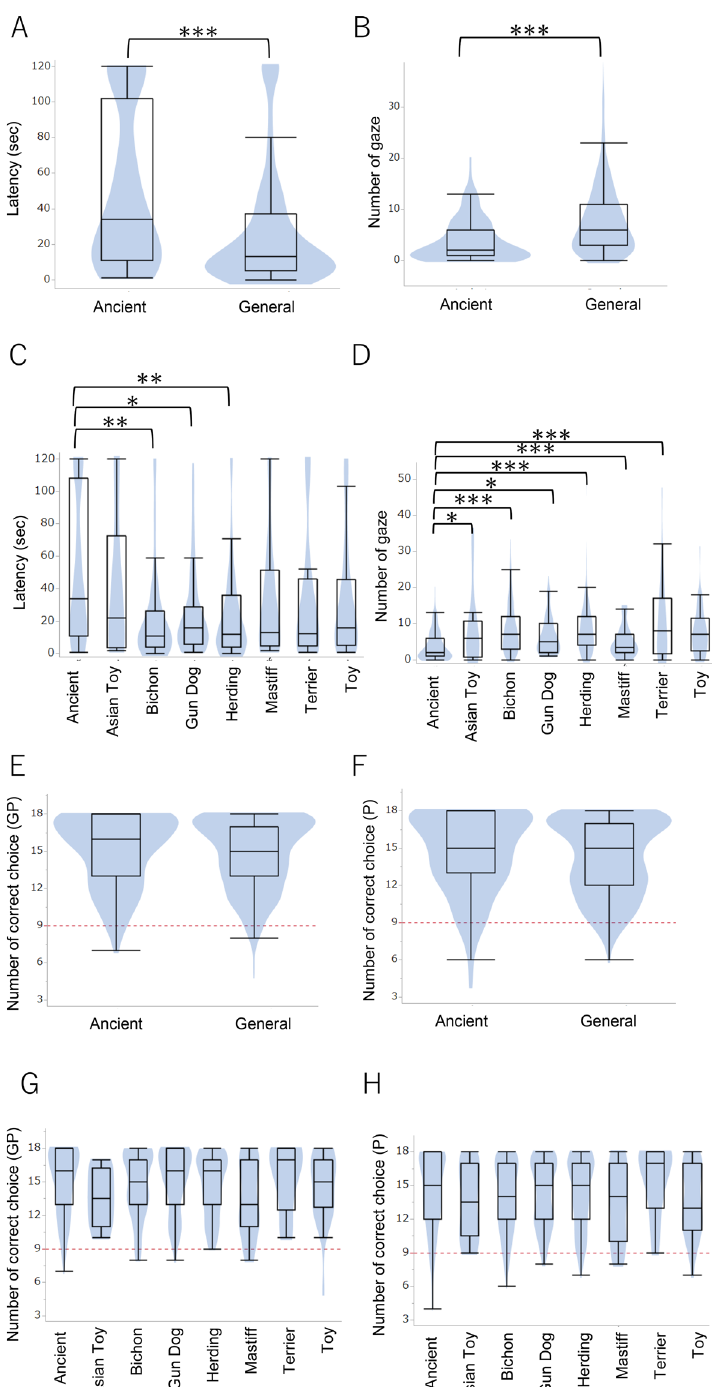
Figure 1. Breed comparisons of the problem-solving test ( A – D ) and two-way choice test ( E – H ). The Ancient breeds showed longer latency before looking back at the experimenters than the General breeds ( A ), particularly the Bichon, Gun Dog and Herding groups. The Ancient breeds also gazed toward the experimenters less often than the general breeds ( B , D ). In contrast, there was no breed difference found in the two-way choice test ( E – H ). * p < 0.05, ** p < 0.01, *** p < 0.001 (GLM followed by Bonferroni post-hoc